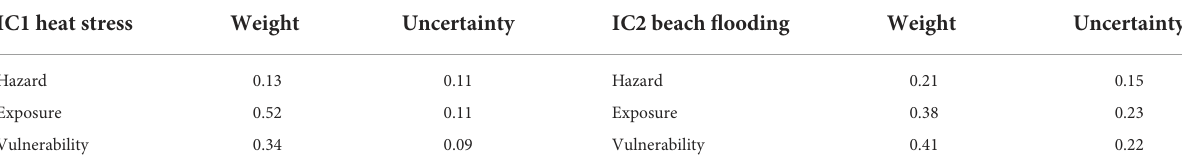
TABLE 3 Weights and uncertainties among level-1 components of the risk for both impact chains.